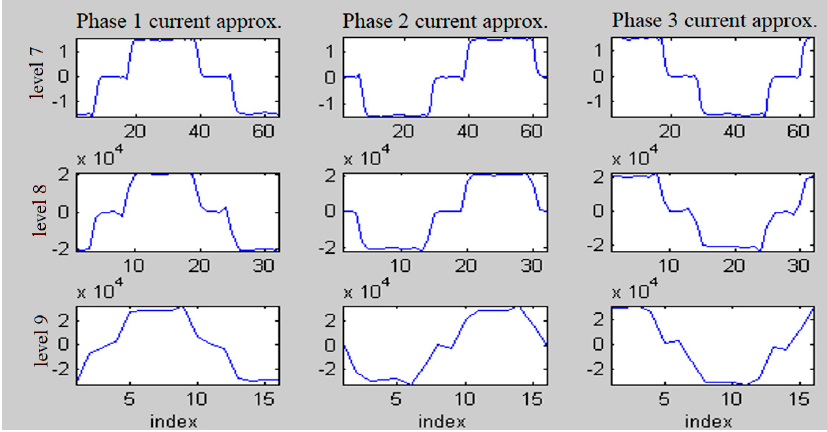
Figure 17. Vectors of approximations for currents, levels 7–9, first case study.